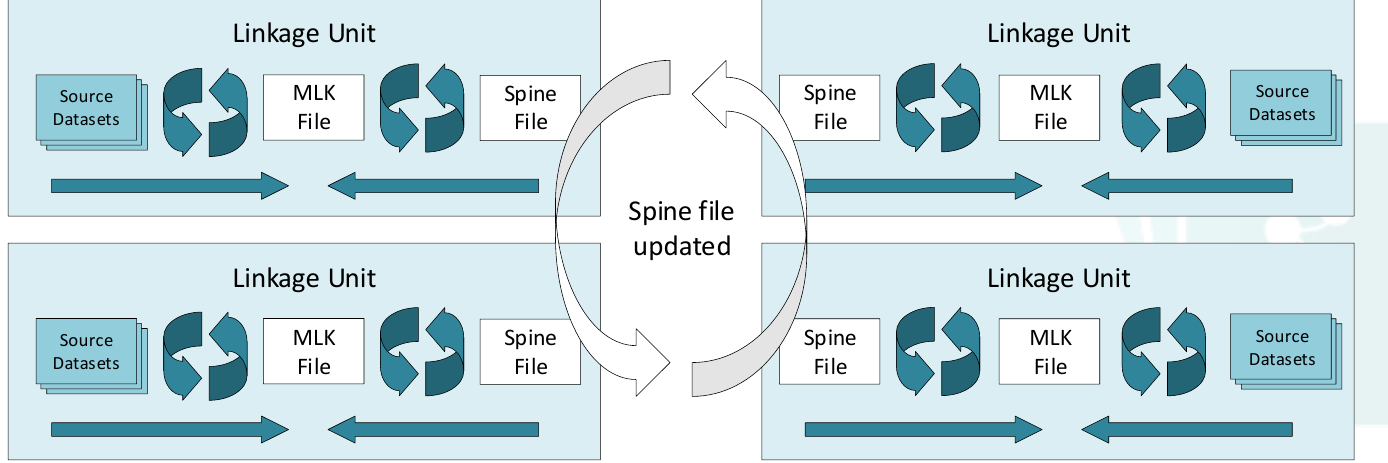
Figure 1: An example of a distributed model. Each linkage unit receives the same spine file; they each link their own jurisdictions datasets to this spine, creating their own ‘master linkage key (MLK)